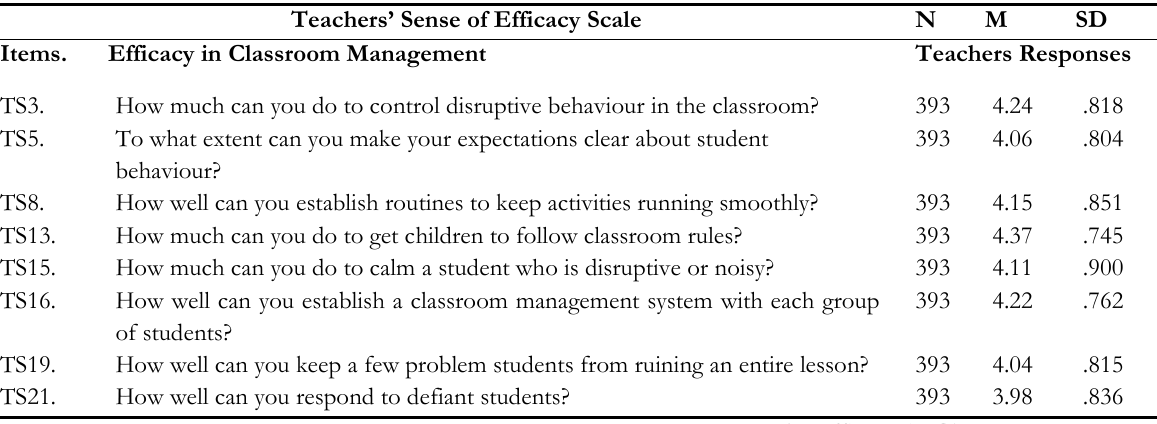
Table 3: Descriptive Statistics for 3 rd Factor of Teachers’ Sense of Efficacy Teachers’ Sense of Efficacy Scale